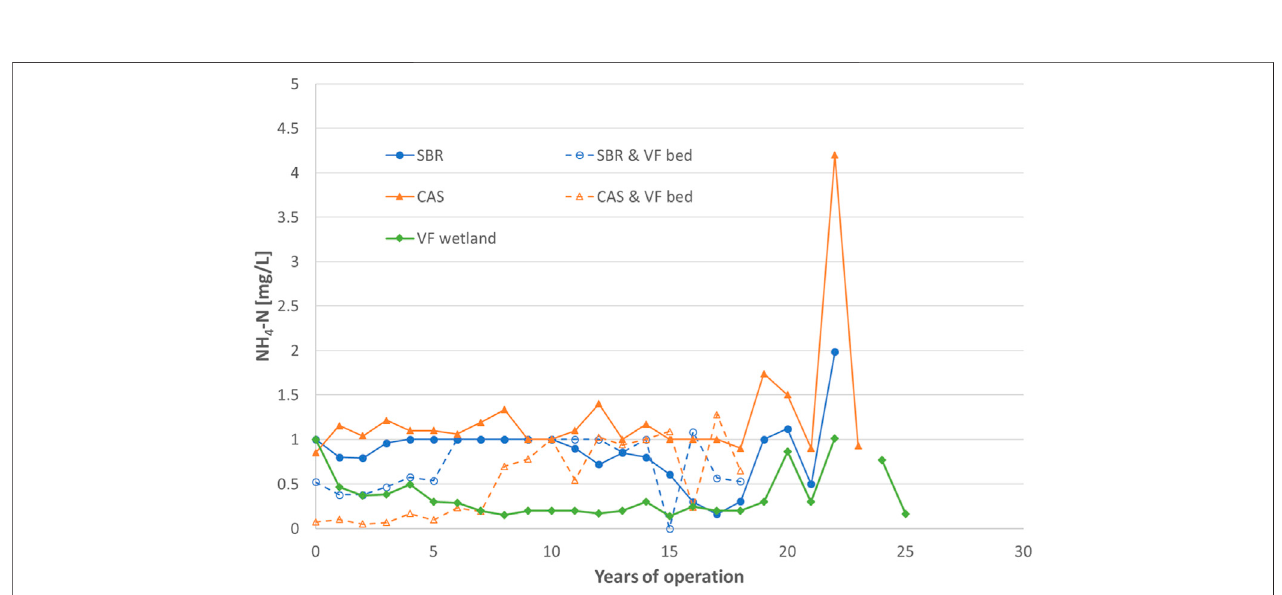
FIGURE8| Median values oftheNH 4 -N ef fl uent concentrationsoftechnologies withor without VF beds and VF wetlands inrelation totheage ofthesmall WWTP.